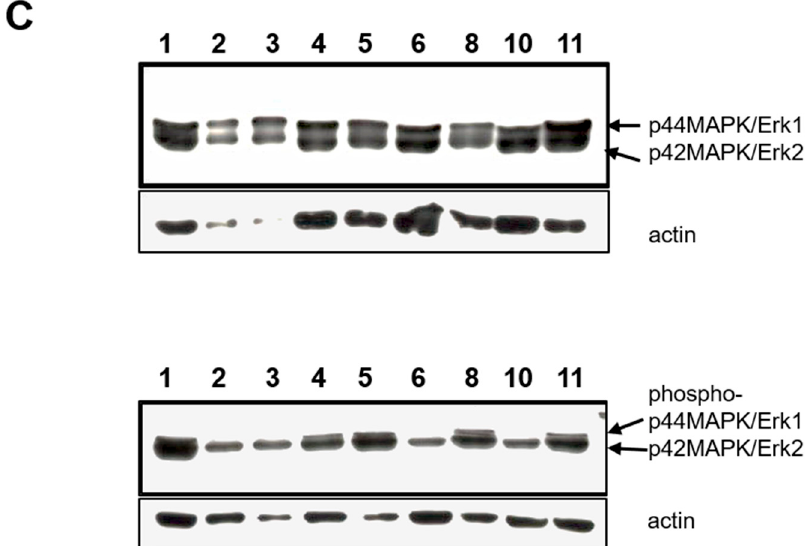
Figure 6. Phosphorylation of Receptor tyrosine kinases and MAP kinases in Wilms cells. ( A ) Human Phospho-RTK array. Each RTK is spotted in duplicates. Representative examples of results for Wilms1, imWilms1 cultured at 37 °C and Wilms8 are shown. The intensity of the spots corresponds to the level of phosphorylation of the proteins. The strongest phosphorylated receptors are highlighted with an arrow and their names are listed. For example, FGFR1 phosphorylation is stronger in nonimmortalized Wilms1 cells, and ERBB3 is more phosphorylated in imWilms1 cells. All other Wilms cells have similar phosphorylation patterns. ( B ) Human Phospho-MAPK array. Examples for Wilms1, Wilms3 and Wilms5 are shown (top part of panel). Later the design of the array format and order of spotted MAPKs changed, an example of this newer format is shown for Wilms10. Some of the proteins are not represented on the older format (top panel). ( C ) Western blot of protein extracts from the Wilms tumor cell lines and probed with pErk1/2 (top) and phospho-pErk/2 antibodies. The number on the lanes corresponds to the extracts from the respective Wilms cell lines. The same blot was reprobed with an actin antibody as loading control. The original film is shown in Figure S12.